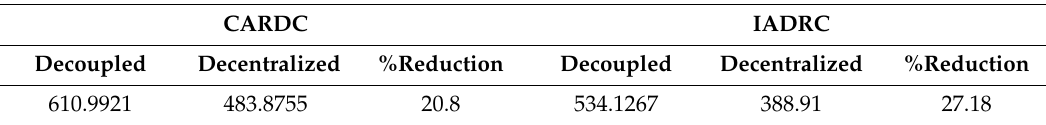
Table 7. Total control energy (ISU 1 + ISU 2